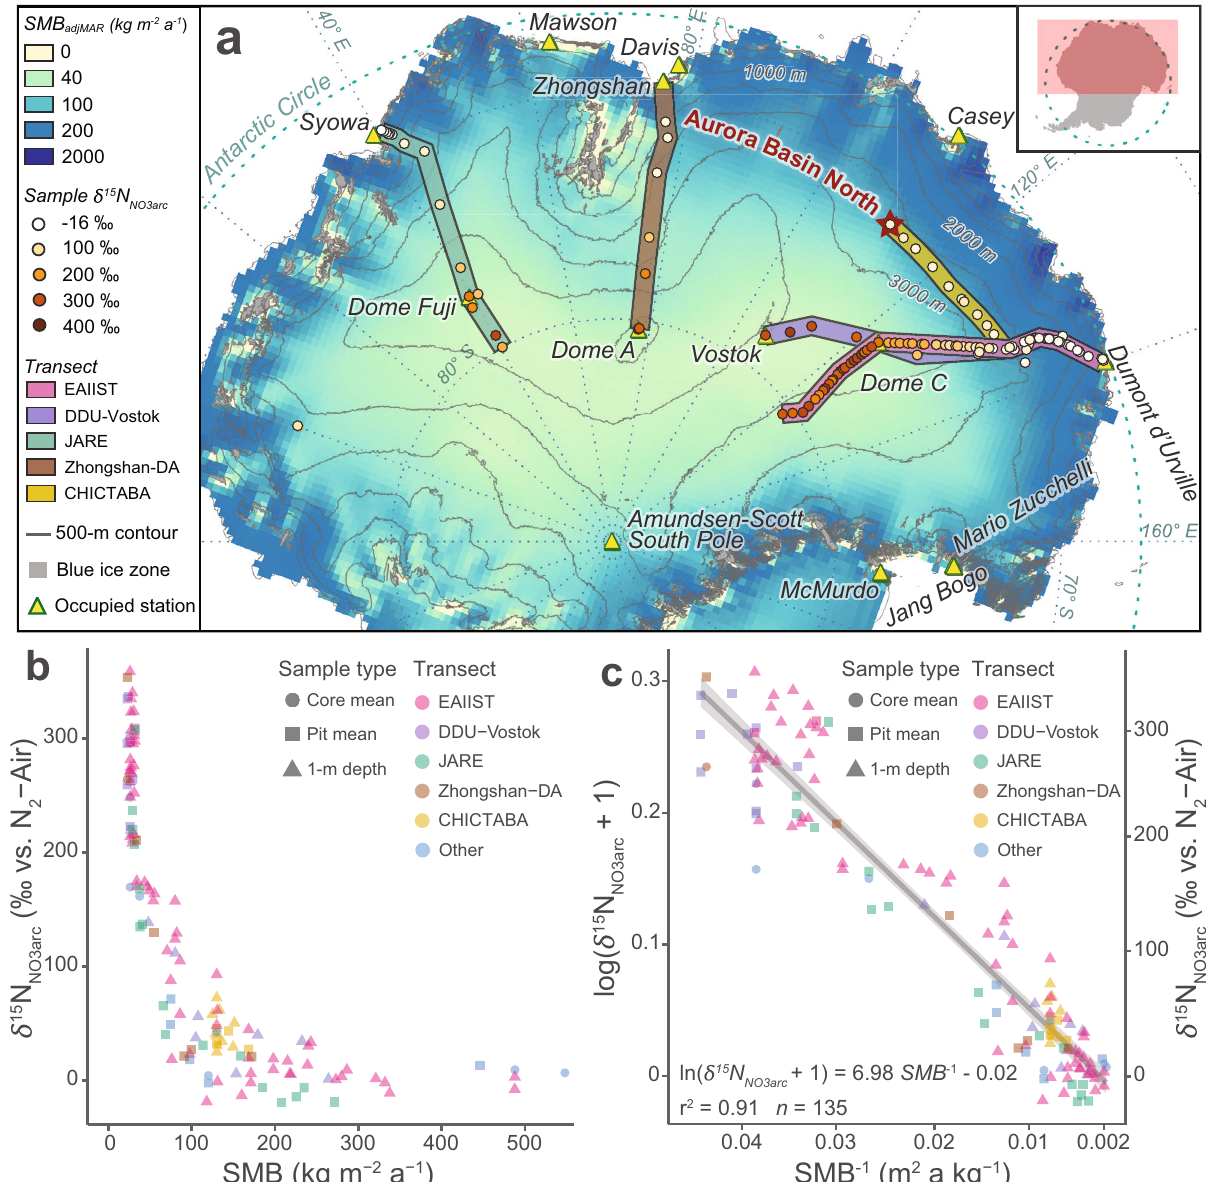
Fig. 2 The relationship between Antarctic snow δ 15 N NO3arc and surface mass balance (SMB). a Map of East Antarctic sites sampled for δ 15 N NO3arc along different scienti fi c and logistic transect routes. Colored circles indicate the locations and δ 15 N NO3arc values of samples included in our fi eld data set, with δ 15 N NO3arc data from the EAIIST (pink) and CHICTABA (yellow) transects newly reported here. The base map SMB data were modeled by MAR adjusted for dry site bias (see Methods) with elevation contours from REMA 11 overlaid. Preservation of NO 3 − is not expected in blue ice zones (gray solid polygons) due to very low or negative SMB and wind scouring 76 . Presently occupied stations in the CONMAP database are shown as labeled triangle icons for spatial reference. b Scatter plot of δ 15 N NO3arc vs. SMB for all sites in the fi eld dataset. The color of the points corresponds to the transects where the samples were collected as shown in a , and the shape of the points corresponds to the sampling method (i.e., snow core, snow pit, or 1-m depth layer). c Scatter plot and linear regression of (1) using all sites in the fi eld dataset. The linear regression (gray solid line) is shown with shaded 95% con fi dence intervals, and regression parameters are displayed at lower